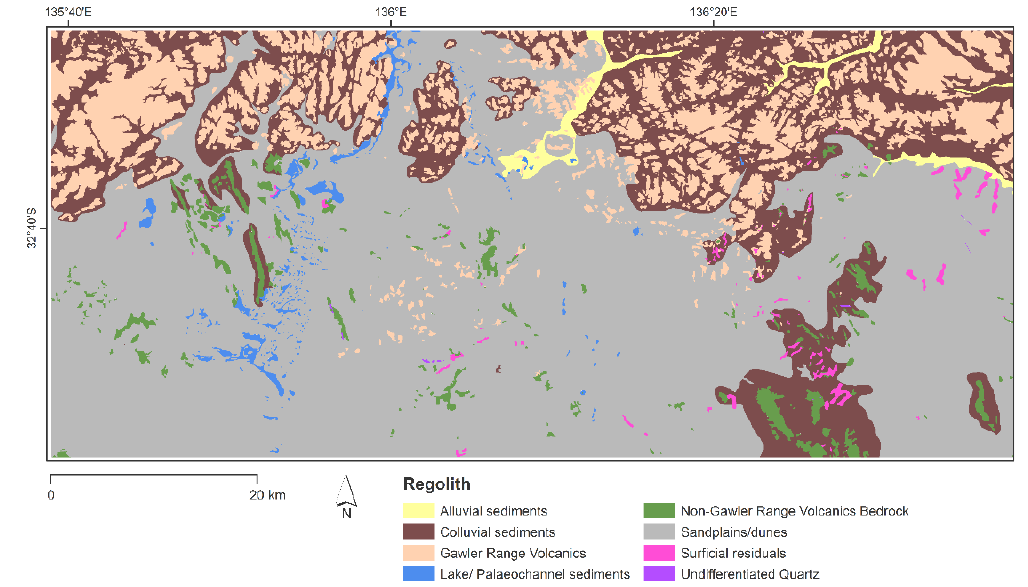
Figure 4. Clustered Regolith Mapping Unit (CRMU) map of the study area after aggregation based on the description of regolith material.